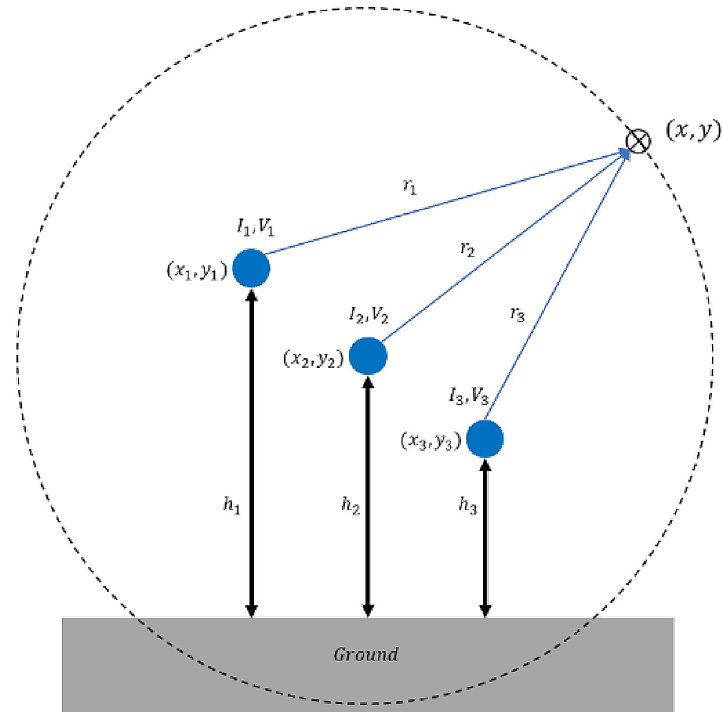
Figure 3. Geometrical illustration for the magnetic and electric field calculation.